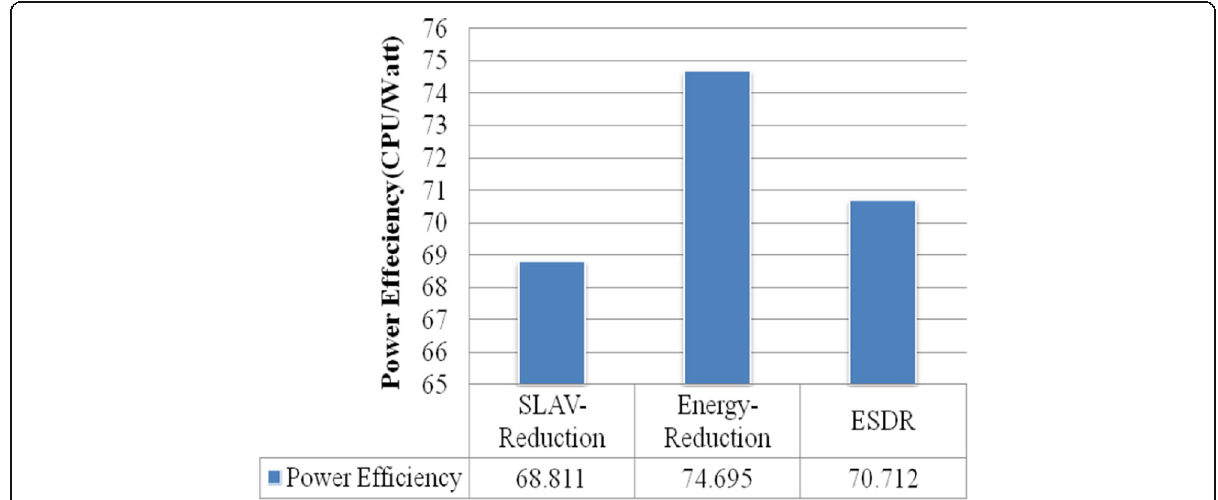
Fig. 3 Comparison of power efficiency in different approaches